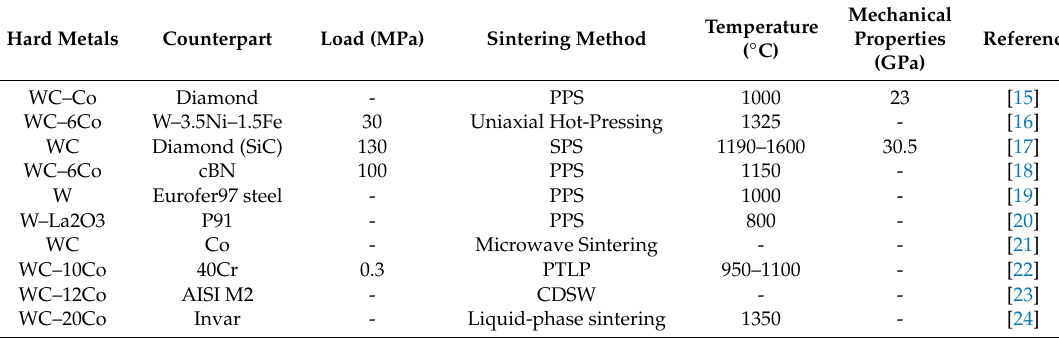
Table 1. Dissimilar cemented carbide bonds prepared by sinter-bonding methods. PPS, pulse plasma sintering; SPS, spark plasma sintering; PTLP, partial transient liquid-phase bonding; CDSW, capacitor discharge